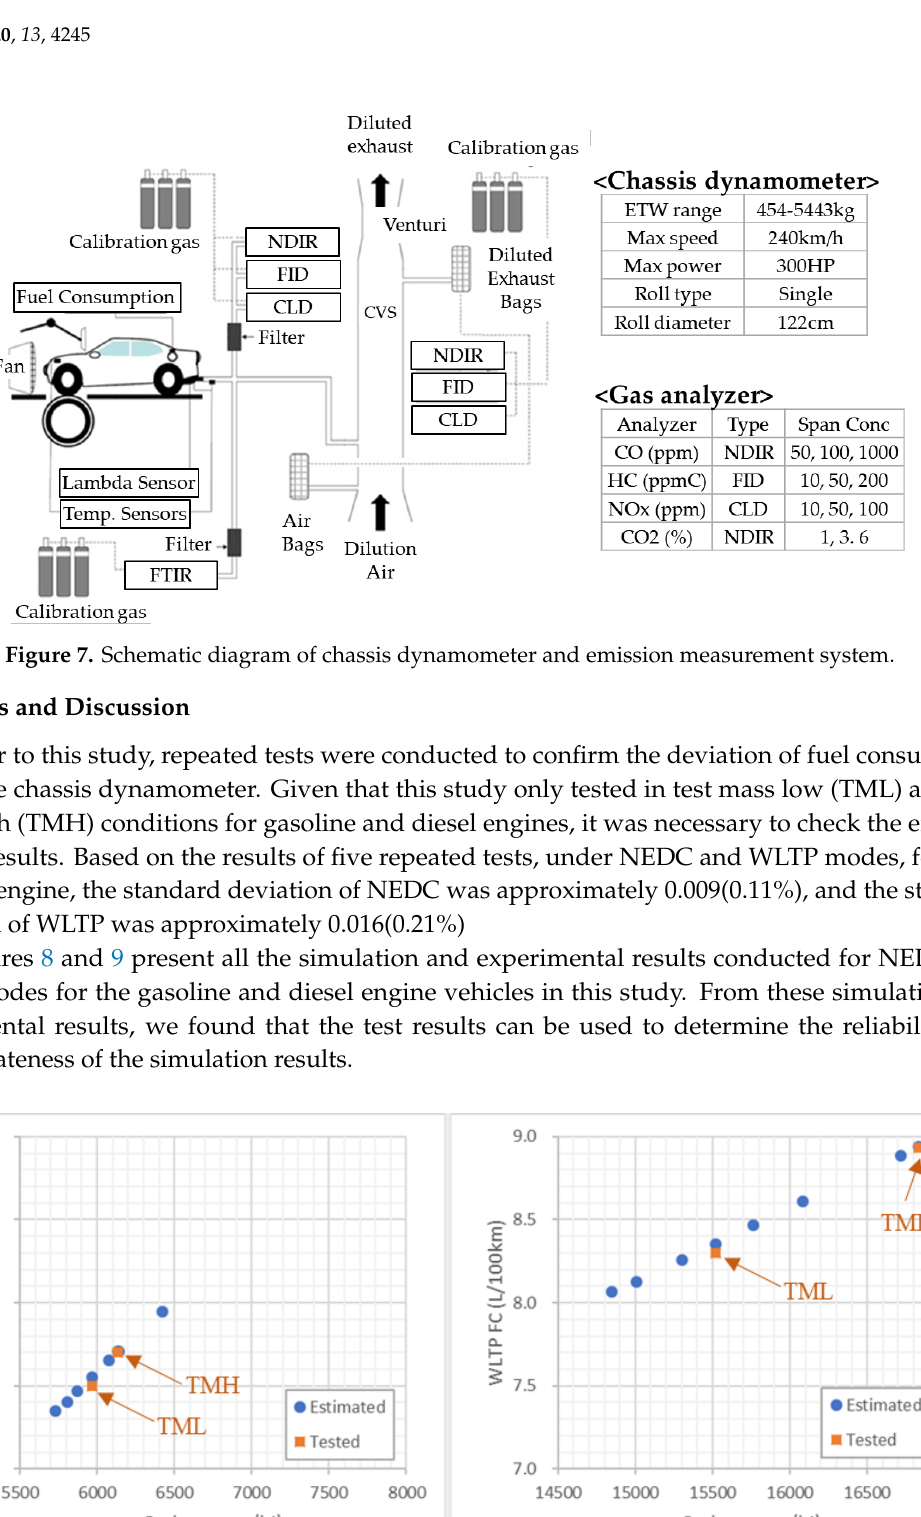
Figure 8. Fuel consumption under NEDC and WLTP according to the cycle energy of 1.6-L gasoline T-GDI .